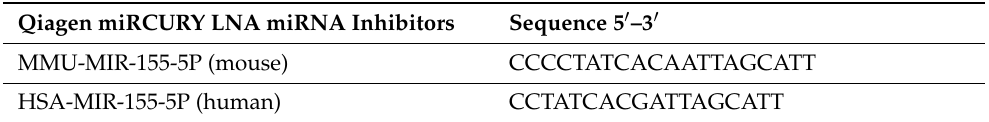
Table 1. miRNA-155 inhibitors. Qiagen miRCURY LNA miRNA Inhibitors Sequence 5 (cid:48) –3